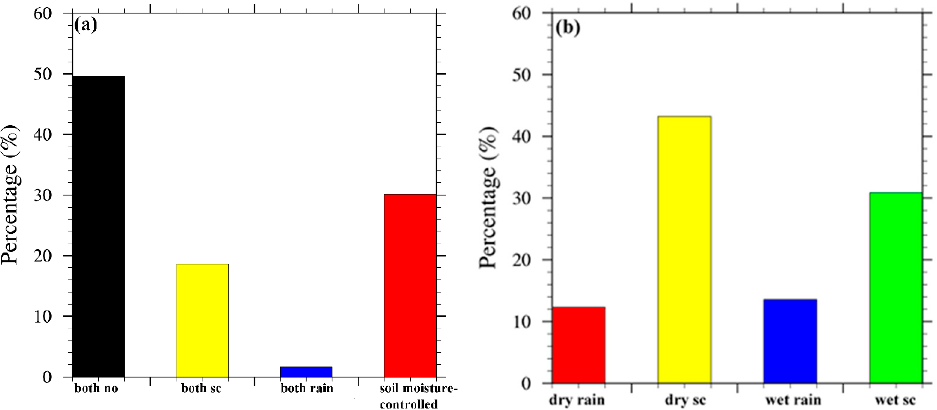
Figure 7. The probability distributions of atmosphere-controlled cases ( a ) and soil moisture-controlled cases ( b ).